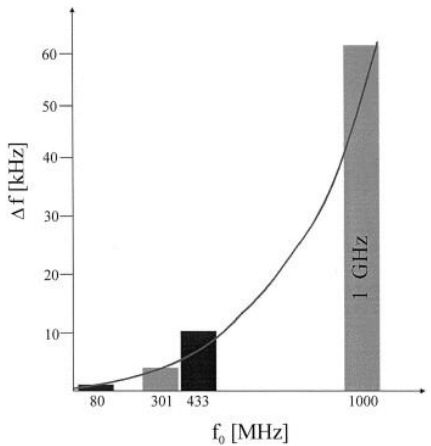
Figure 4. Sensor responses of different SAW devices for 1000 ppm of toluene. All the devices are coated with the same recogntion layer i.e., permethylated β-cyclodextrin linked with hexafluorobenzene having a layer height of 60 nm, and the basic frequencies of the devices were 80, 301, 433 and 1000 MHz. Adapted with permission from [47], copyright (1998) Elsevier.